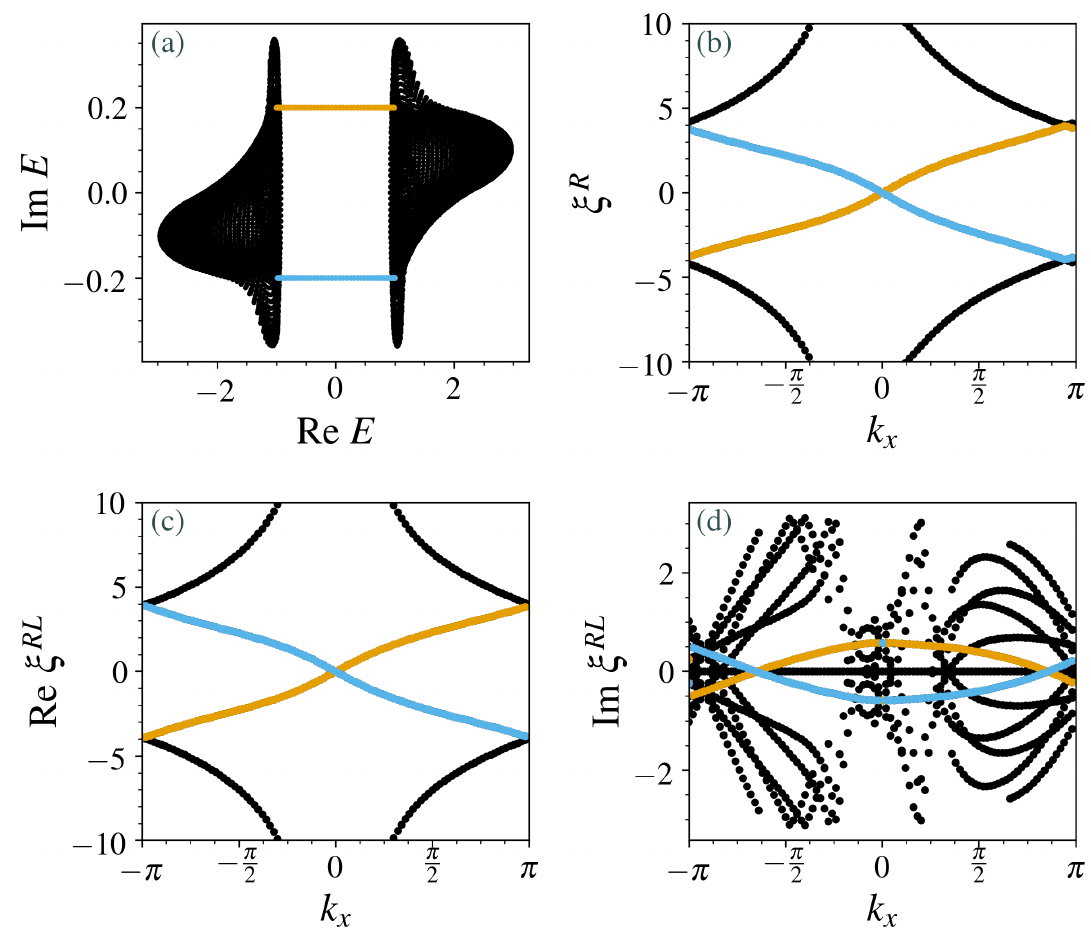
= 0.2, Figure 9: (a) Energy spectrum of the non-Hermitian Chern insulator for γ x γ = 0.3, δµ = 0.1 and µ = 1, deep in the non-Hermitian topological phase on a y cylinder geometry. Two edge modes of opposite chirality with finite imaginary part are present. (b) Right entanglement spectrum obtained for the same parameters as a function of the conserved momentum k . Topological edge modes are also present. x (c-d) Real and imaginary part of the biorthogonal entanglement spectrum. The chiral edges have the same sign of the imaginary part as in the original Hamiltonian close = to k x